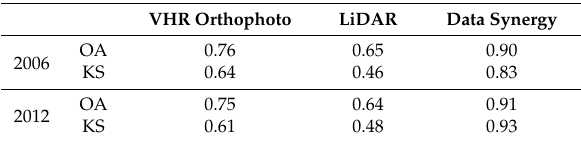
Table 2. Classification accuracies based on either VHR Orthophotos, Light Detection and Ranging technology (LiDAR) or data synergy for 2006 and 2012. OA: Overall accuracy. KS: Kappa statistic.